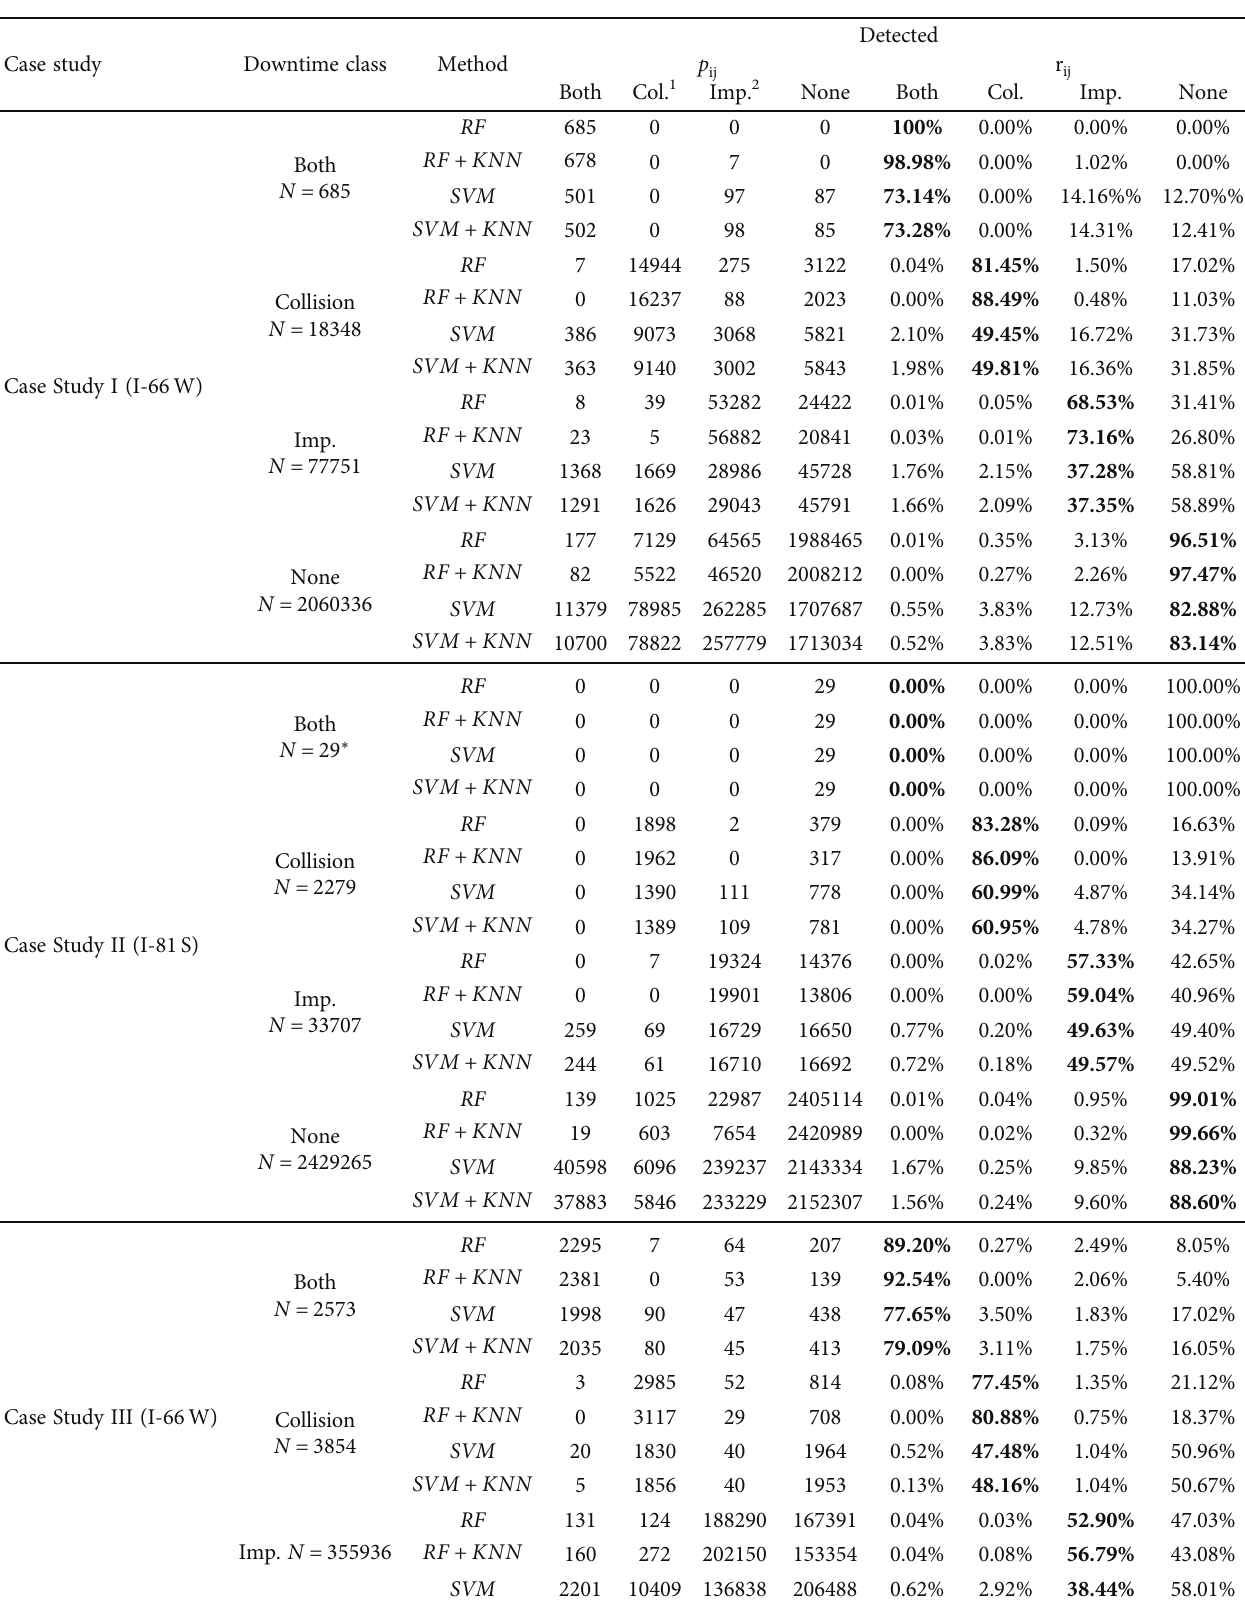
Table 8: Confusion